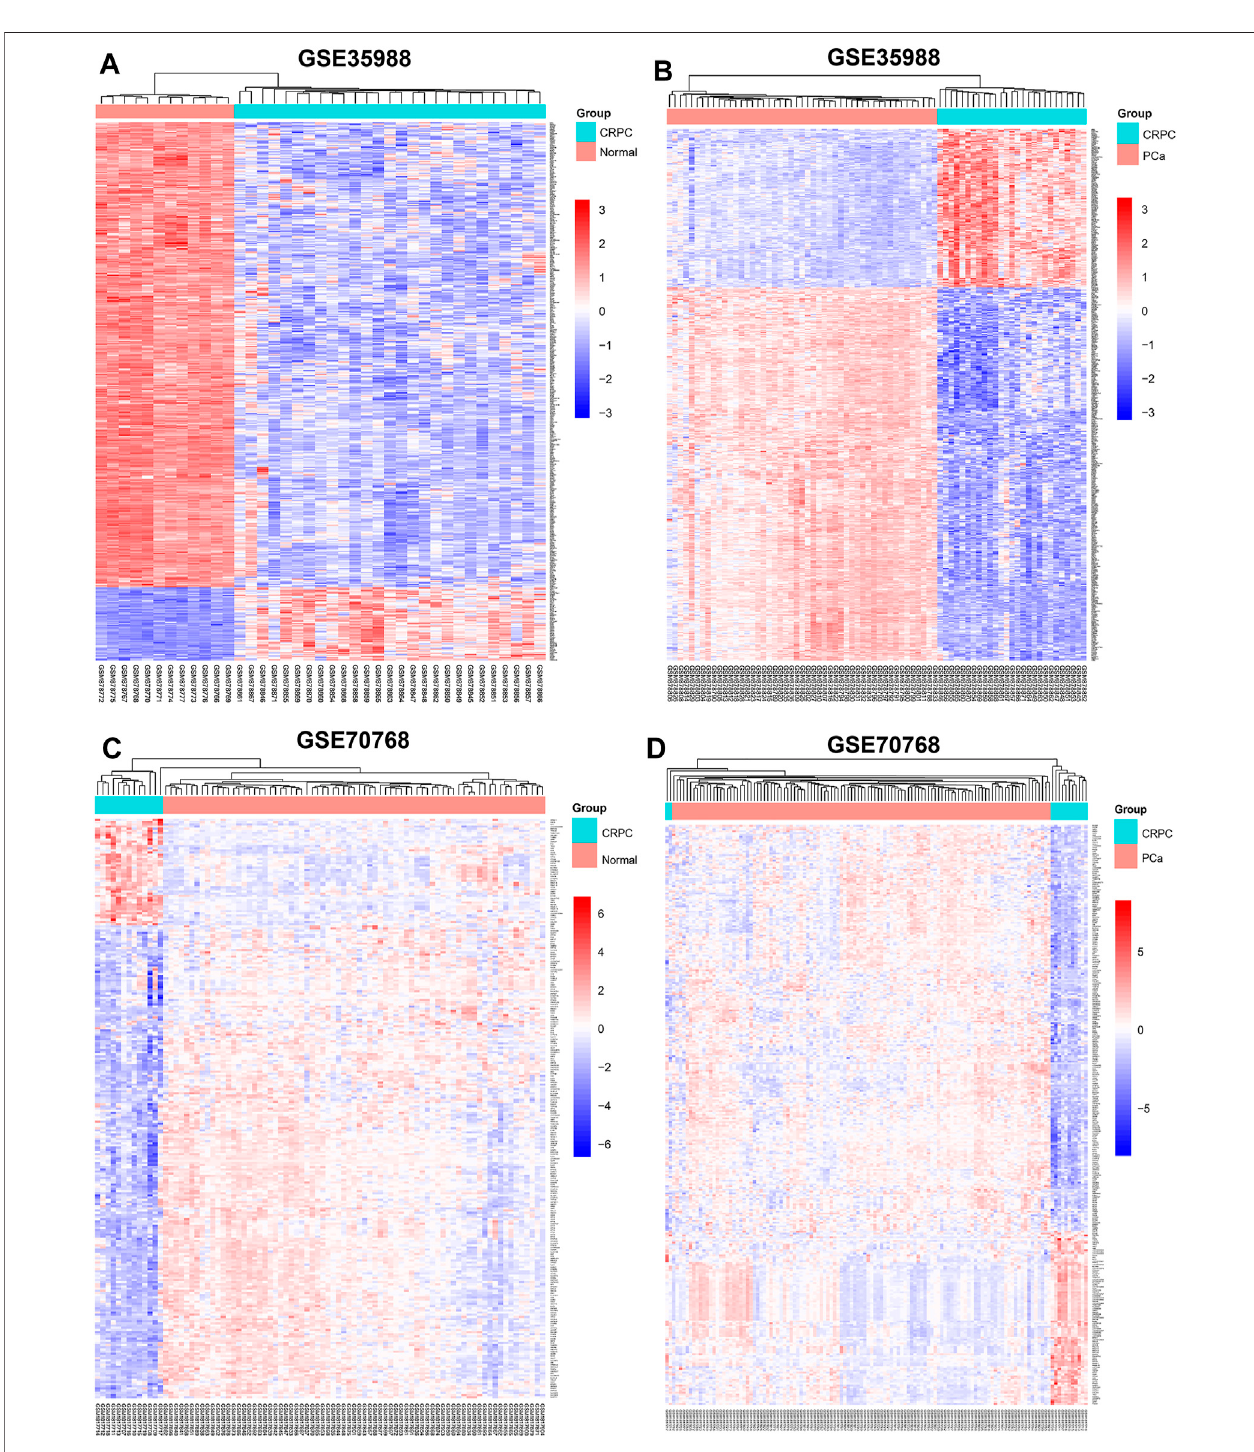
FIGURE 1 | Heatmap of DEGs compared CRPC with normal and PCa samples. (A,C) DEGs of CRPC compared with normal samples in GSE35988 and GSE70768. (B,D) DEGs of CRPC compared with PCa samples in GSE35988 and GSE70768.